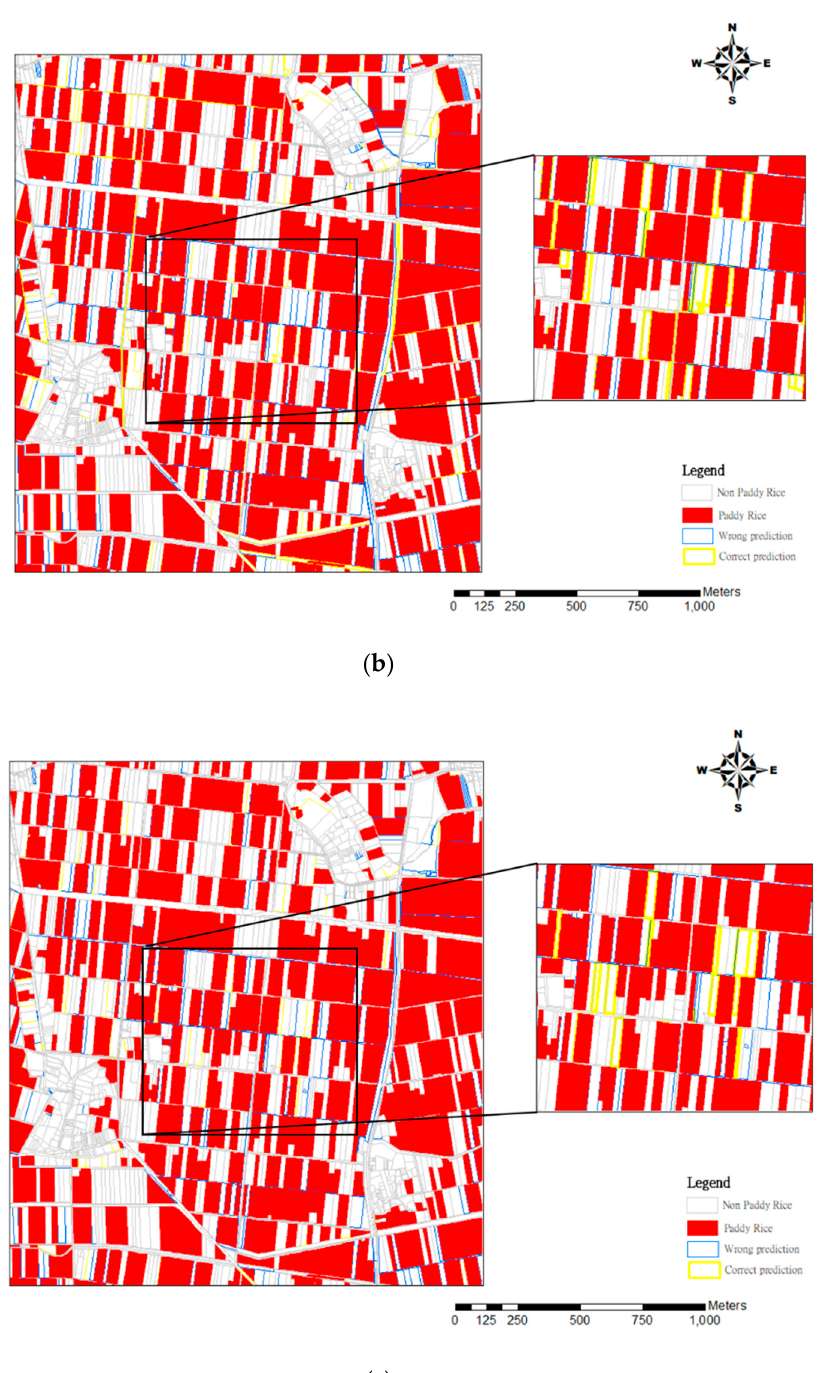
Figure 9. Comparison on hybrid classification and ground truth data, ( a ) SVM, ( b ) NN, and ( c ) DT. Overall, DTW is based on the dynamic programming method for effectively reducing search and comparison time. The multi-scale time series feature similarity indicators developed in this research have the ability to transform multi-dimensional data into two- dimensional information. The reason for applying DTW is because the status of crops is a long-term characteristic. This research shows that time features are helpful for long-term characteristic image classification. In particular, it can be used in small farmland areas and fragile landscapes. Through the integration of DTW data, it can overcome the limitations of the large difference between optical images and radar images. In addition, the different